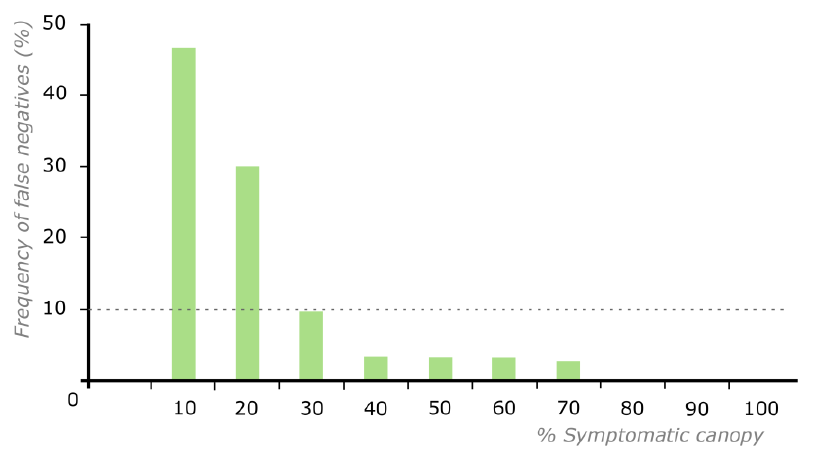
Figure 9. Histogram of false negative detections in Sentinel-2 imagery (2018/2019) as a function of percentage of decline symptoms in the canopy.